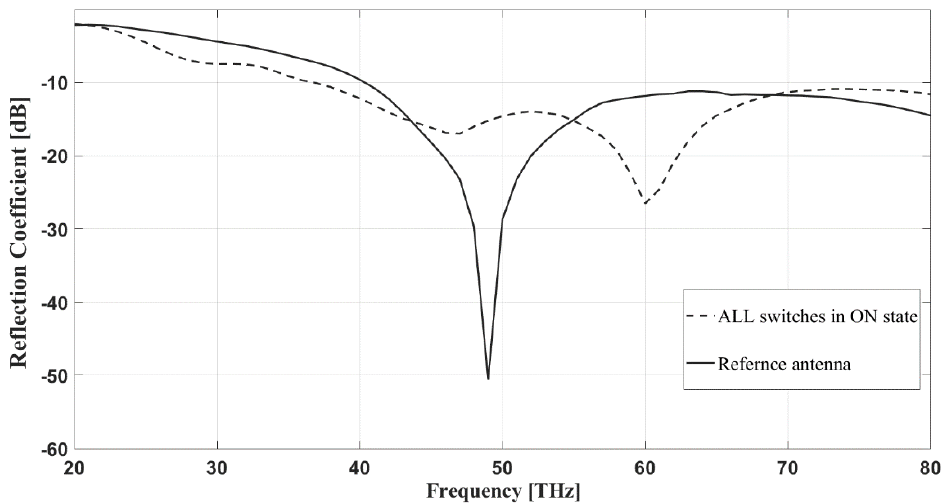
Figure 3. Reference planar antenna geometry ( a ), and substrate geometry ( b ) used for the simulations.